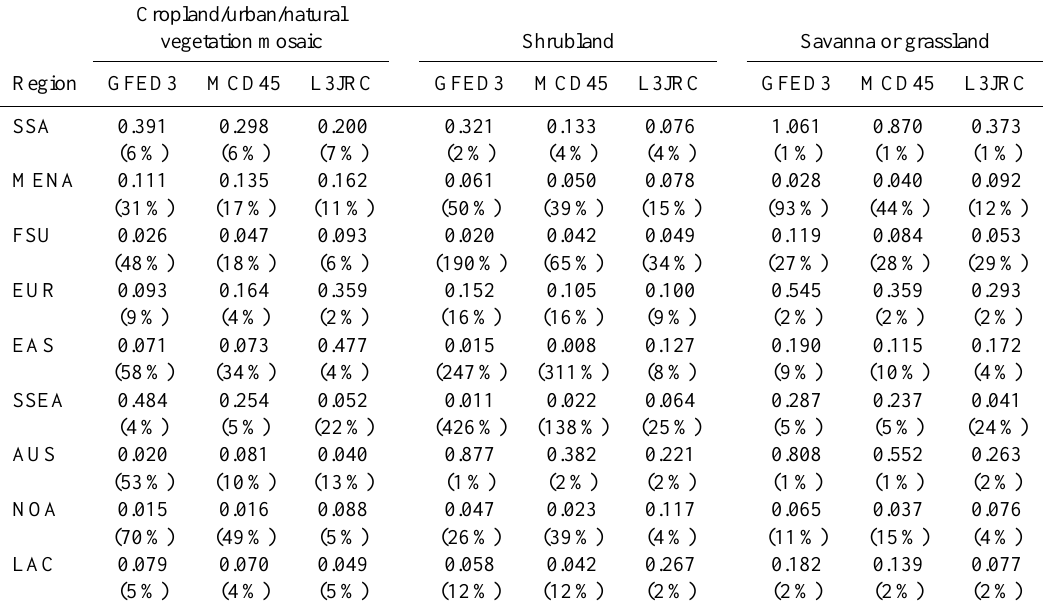
Table A2. Continued for parameter a